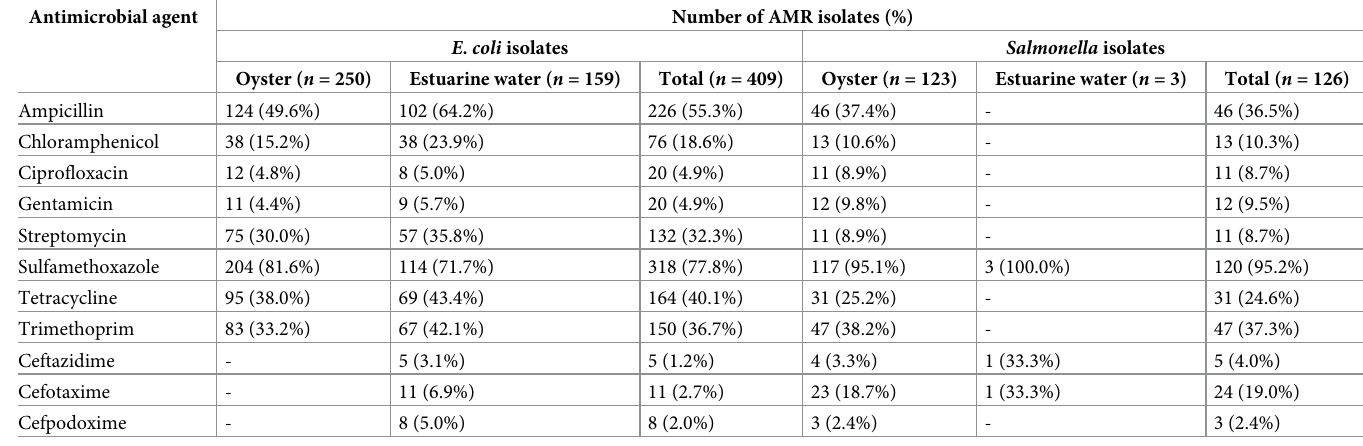
Table 4. Resistance rate of E . coli ( n = 409) and Salmonella ( n = 126) isolates from oyster and estuarine water samples. Antimicrobial